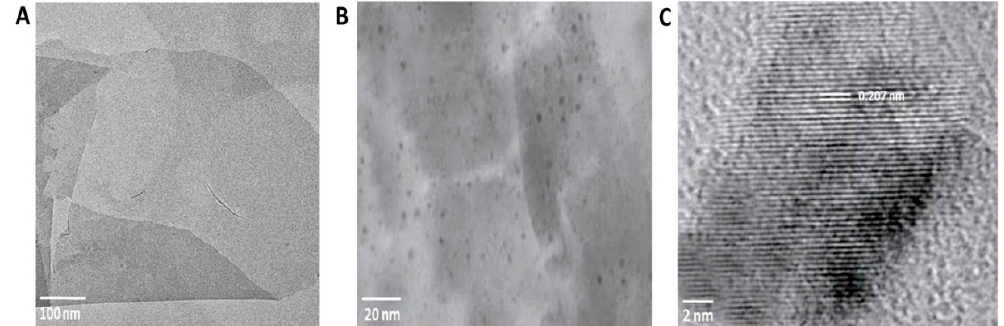
Figure 1. TEM images of ( A ) rGO and ( B ) rGO-CuO NPs. ( C ) EDS pattern of rGO-CuO NPs.